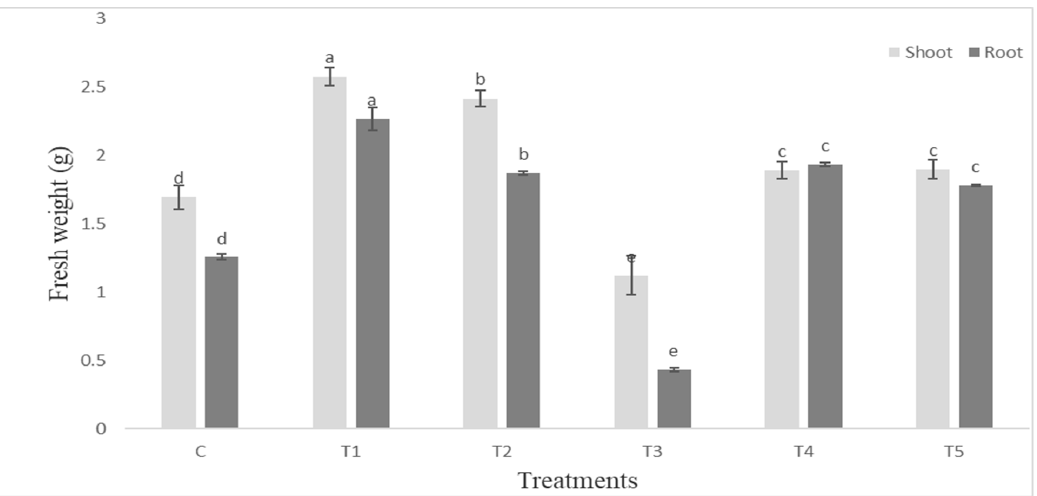
Figure 3. Fresh weight of shoot and root (g) of tomato plant infested with S. litura and under control condition. Data are means of four replicates along with standard error bars. Different letters are indicating significant differences ( p < 0.05) among treatments.